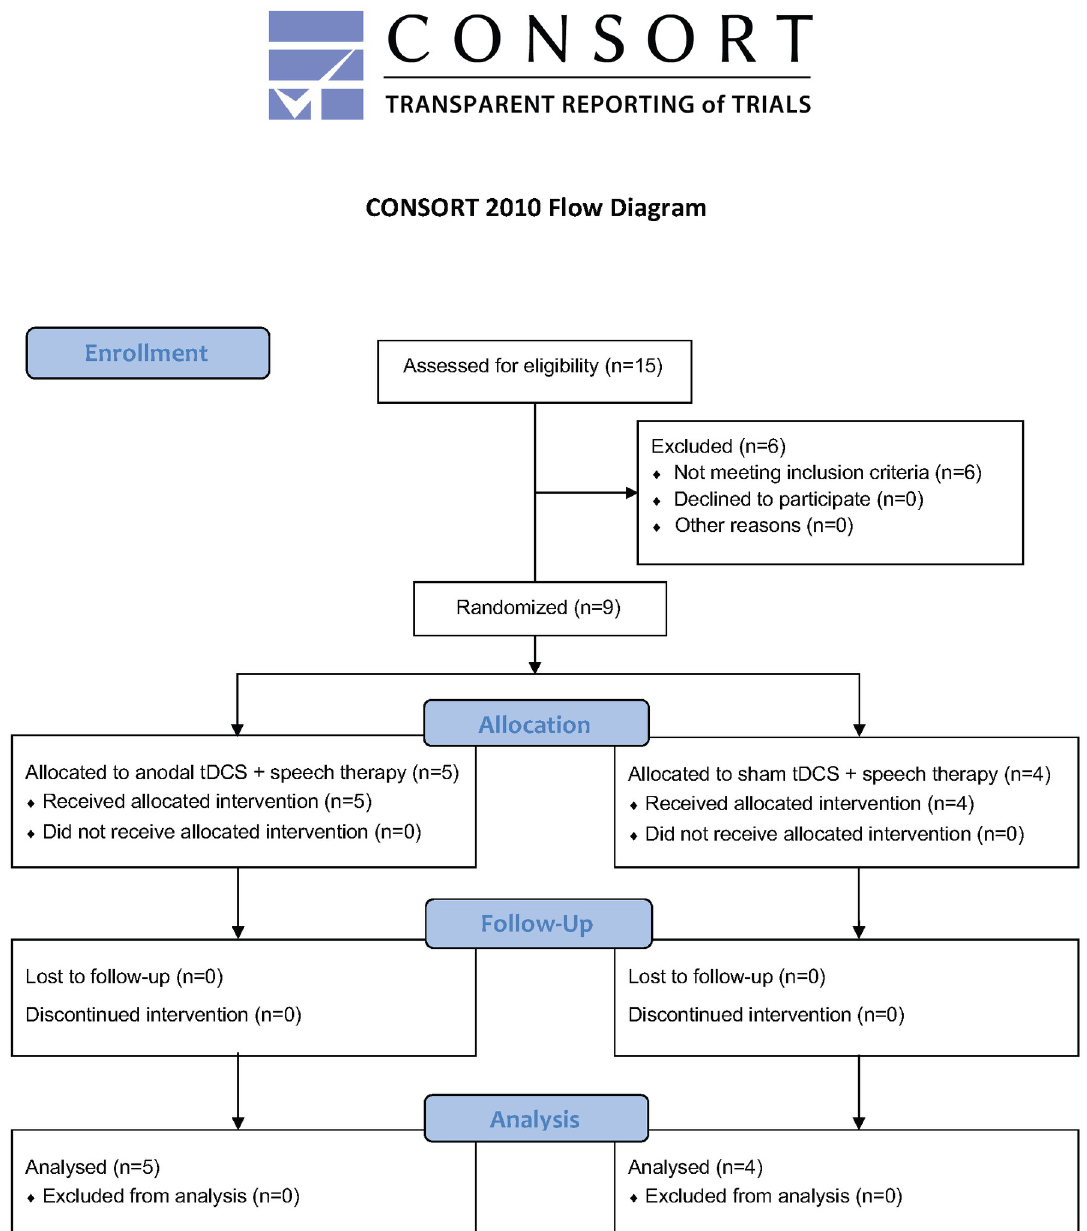
Fig 1. The CONSORT 2010 flow diagram showing the progress through the phases of this